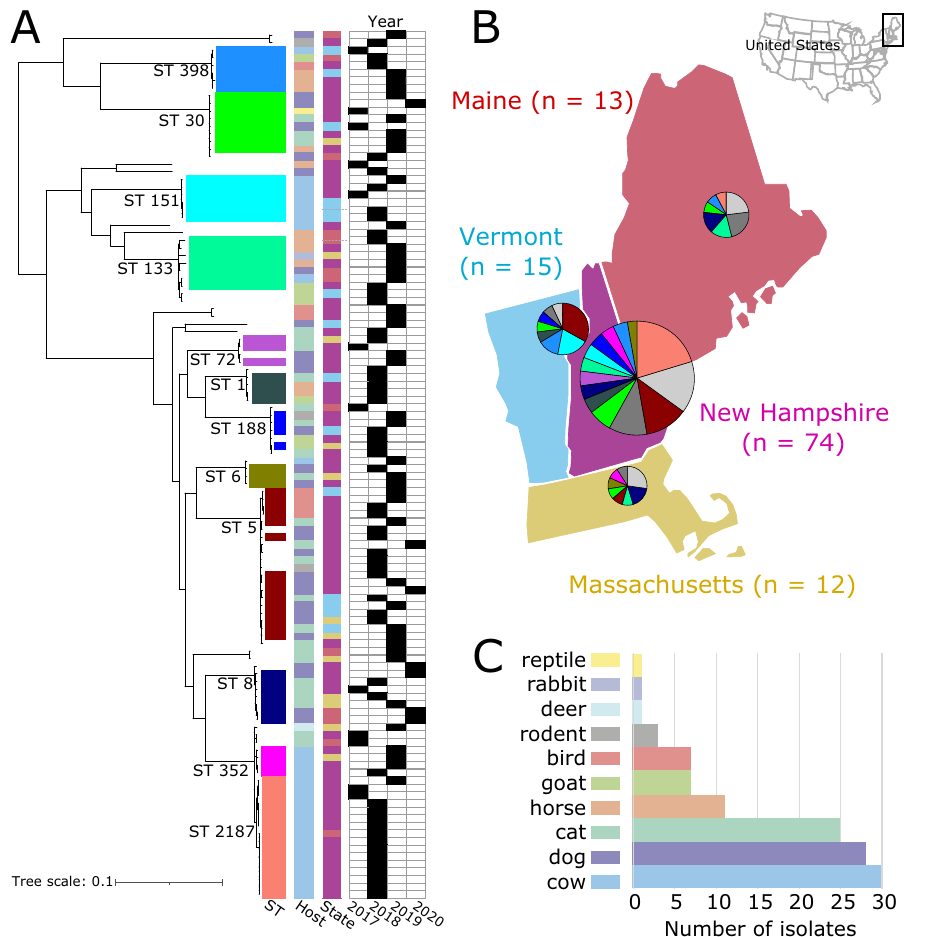
Figure 1. Phylogenetic diversity and sources of animal-associated S. aureus in New England. ( A ) Midpoint- rooted maximum likelihood phylogenetic tree. Tree scale represent the number of substitutions per site. For visual clarity, only those STs with at least three isolates are labeled. ( B ) Geographical distribution of STs. Pie charts show the proportion of major STs shown in panel A. Light gray includes STs consisting of a single isolate and novel STs, while dark gray represents STs consisting of two isolates. The number in parentheses indicates the number of isolates from each state. Maps were created using QGIS v3.22 (https:// www. qgis. org/ en/ site/) ( C ) Number of isolates from different animal